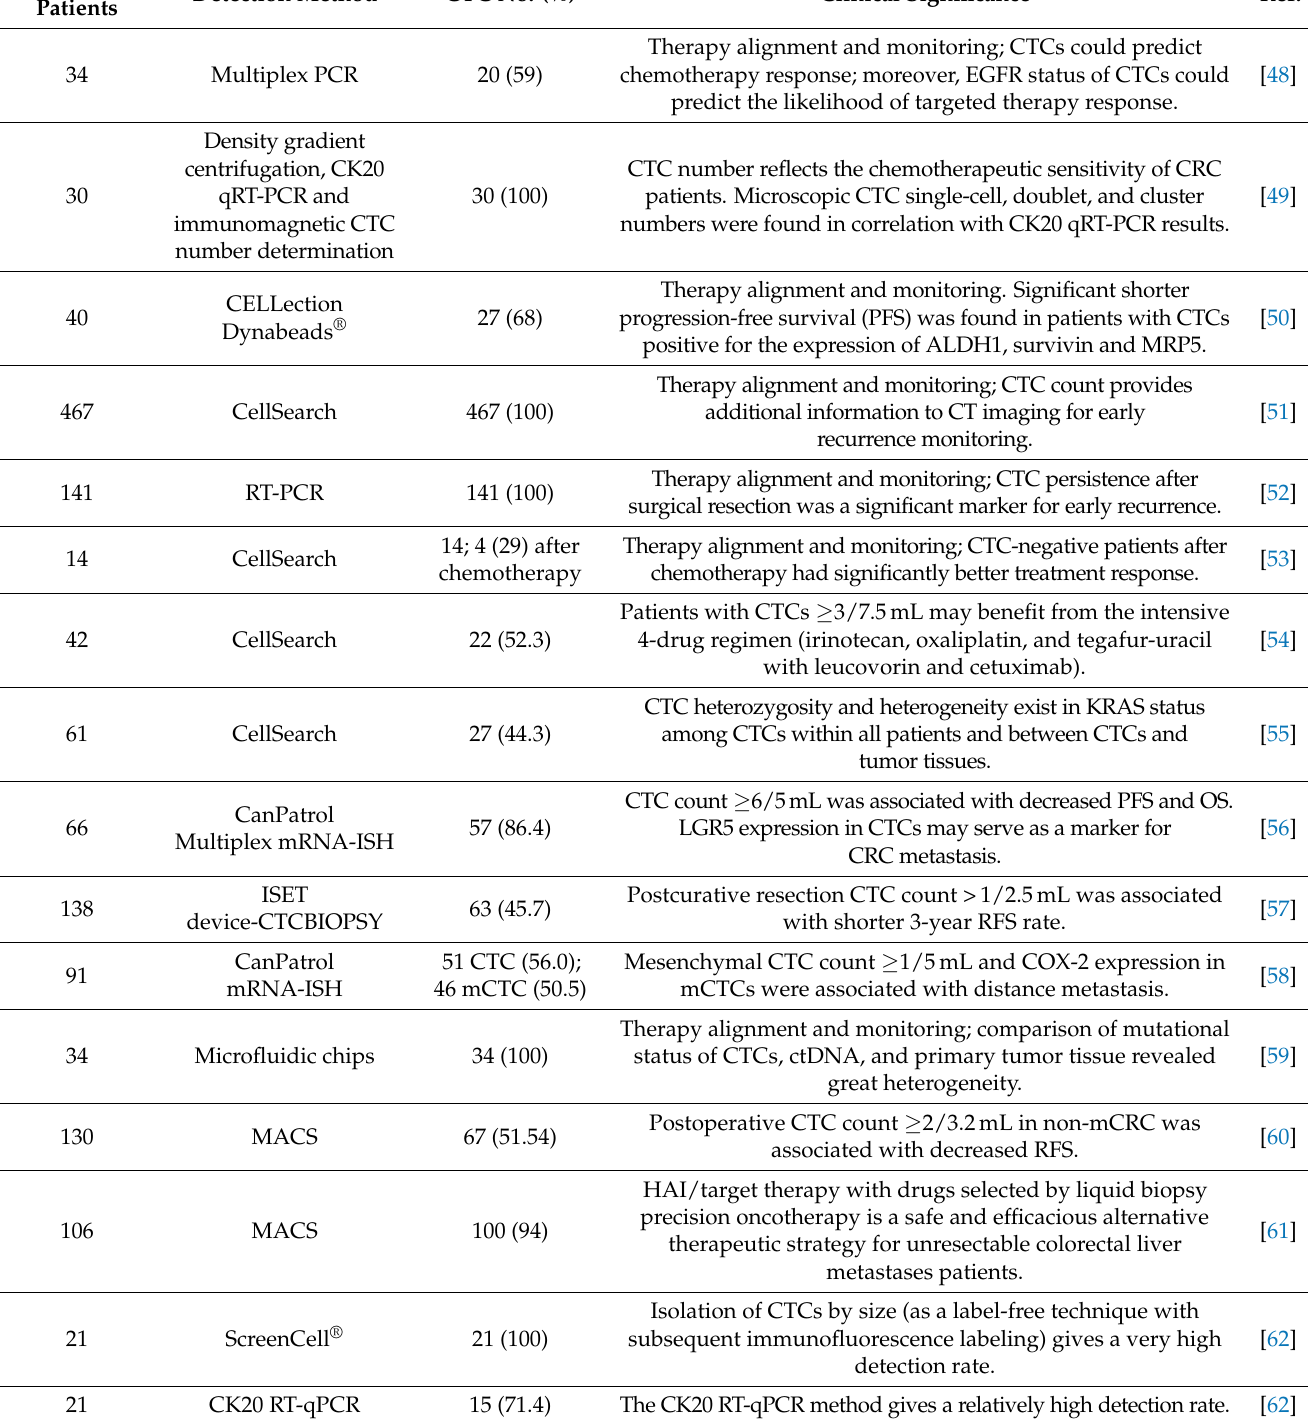
Table 1. Clinical significance of CTCs in colorectal